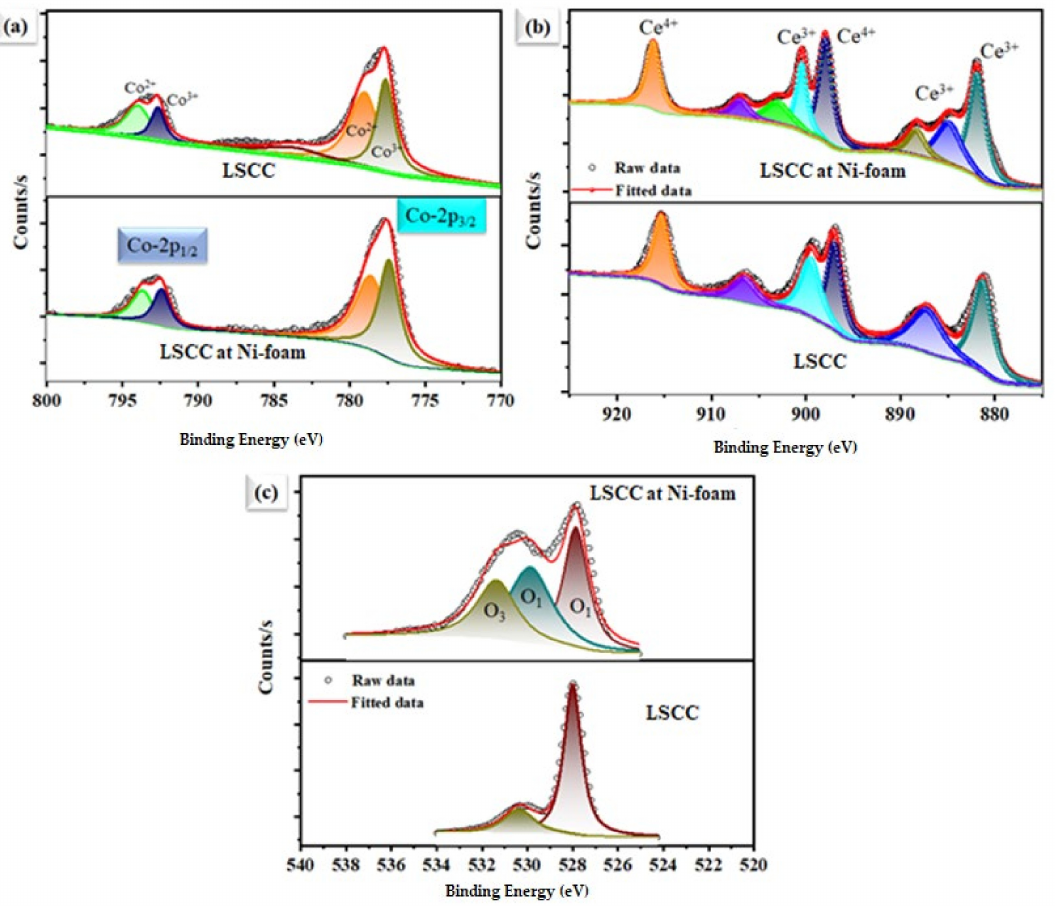
Figure 7. X-ray photoelectron spectra of La 0.2 Sr 0.8 Co 0.8 Ce 0.2 O 3 − δ . Individual powders were embed-